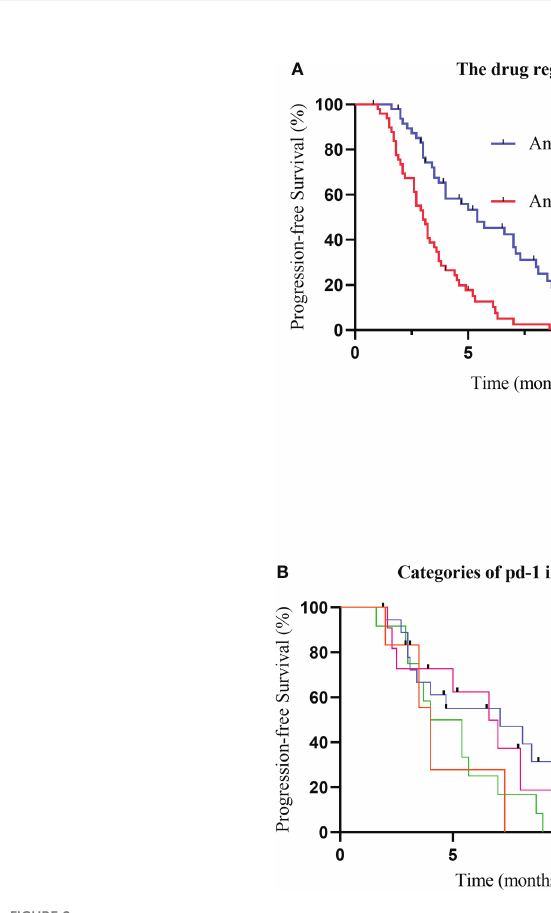
FIGURE 2 Kaplan-Meier plot curves for the PFS of patients in different groups. Compared with anlotinib alone, anlotinib plus PD-1 blockade showed higher mPFS (P<0.001) (A) . PFS, Progression-Free Survival; PD-1 blockade, Programmed death-1 blockade. PFS of different categories of PD-1